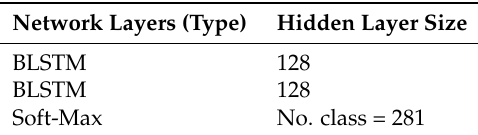
Table 3. The recurrent network layers of the proposed model with their corresponding parameter values. The input size of the Long–Short-Term Memory (LSTM) is a squeezed output of the convolutional layers, which is depicted in Table